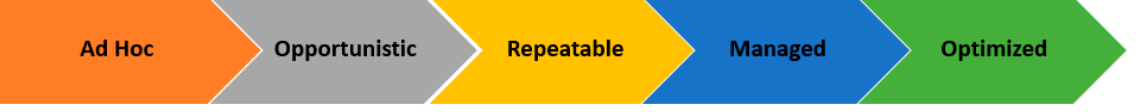
Figure 10. IDC MaturityScapes Stages.